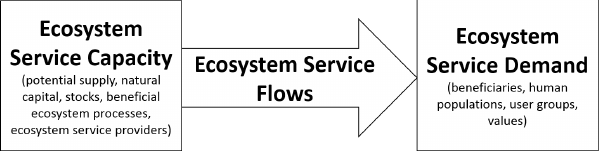
Fig. 2 . Conceptual diagrams distinguishing different components to ecosystem services. For this study, we focus on interactions among capacity-based indicators of ecosystem services.